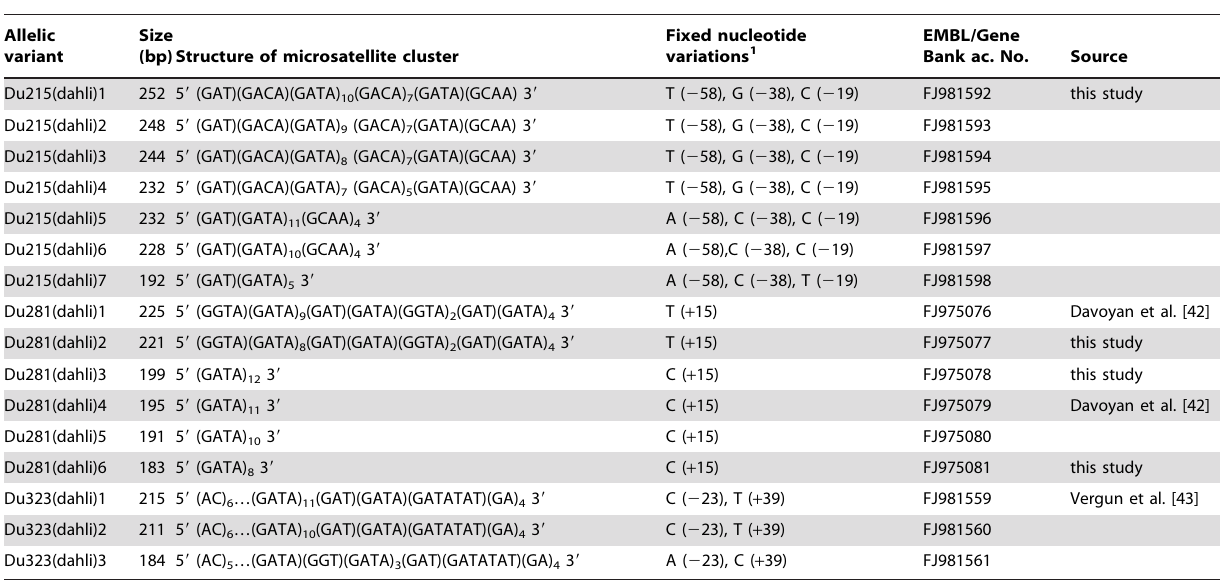
Table 1. Allelic variations of microsatellite containing loci Du215, Du281, and Du323 in parthenogenetic D. dahli species.